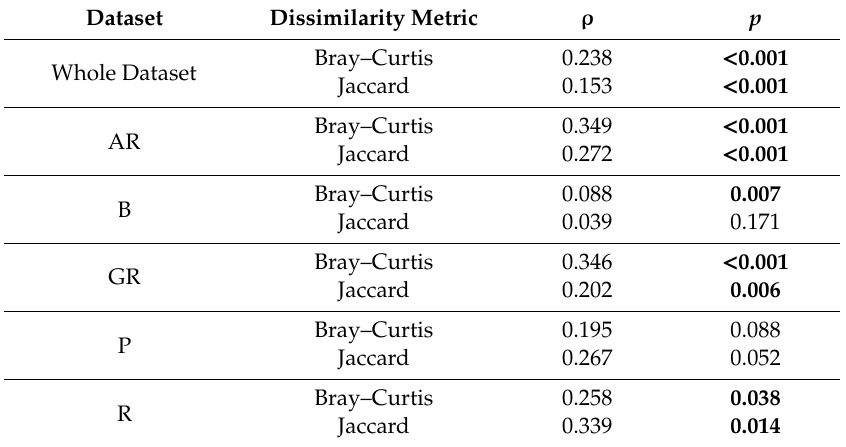
Table 3. Correlation (Spearman’s ρ ) between the Bray–Curtis (log-transformed abundance data) and Jaccard dissimilarity matrices (occurrence data) of plants and lichens. p -values were calculated by using Monte Carlo randomization tests (999 permutations). Significant correlation coe ffi cients are in bold. AR—Shrublands, B—Riparian woods, GR—Dry Banks, P—Swamps, R—Flooded Banks.